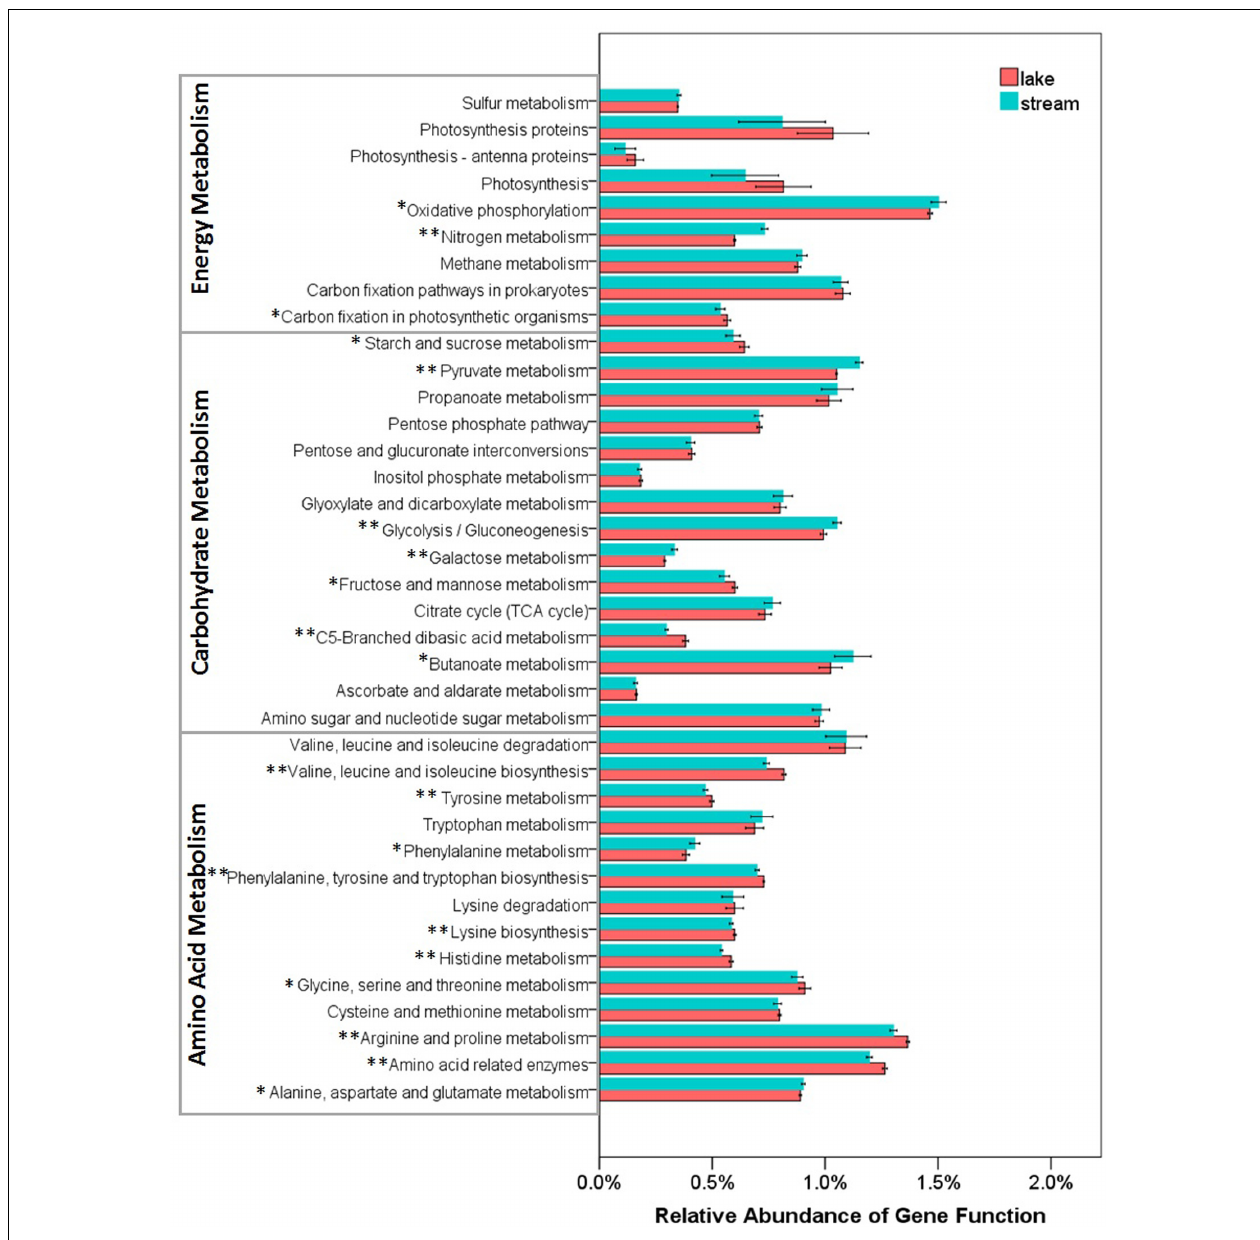
FIGURE 8 | Relative abundance of various predicted functions of microbial communities in lake water and stream biofilms using PICRUSt grouped into level-3 functional categories. ∗ and ∗∗ indicate gene categories that are different between lake and stream at the P < 0.05 and P < 0.01 significant level, respectively.